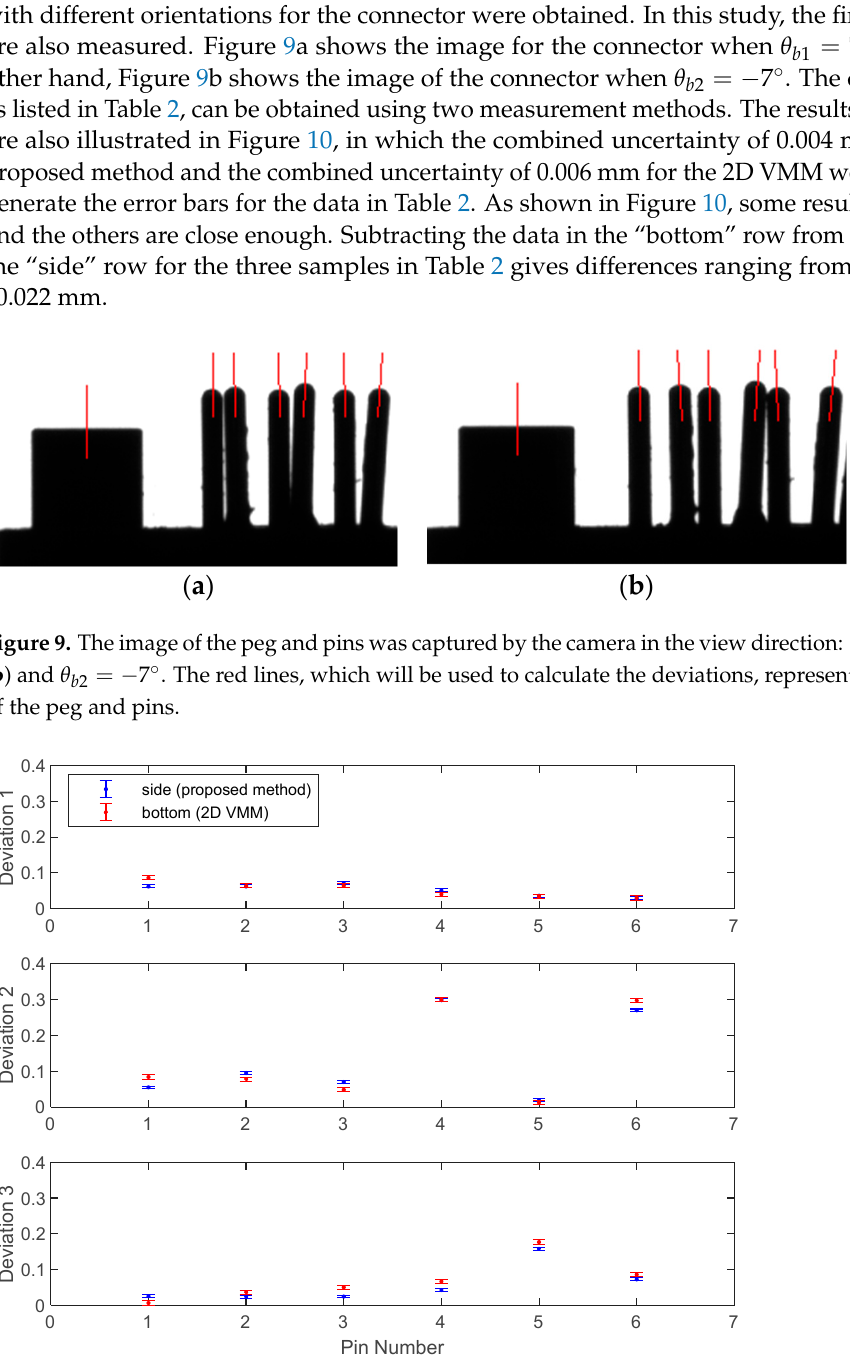
Figure 10. The deviations were obtained using the proposed method and the 2D VMM as in Table 2. Deviations 1, 2, and 3 mean the measurement results of samples 1, 2, and 3. The uncertainty of 0.004 mm for the proposed method and that of 0.006 mm for the 2D VMM were used to generate the error bars for the corresponding data.